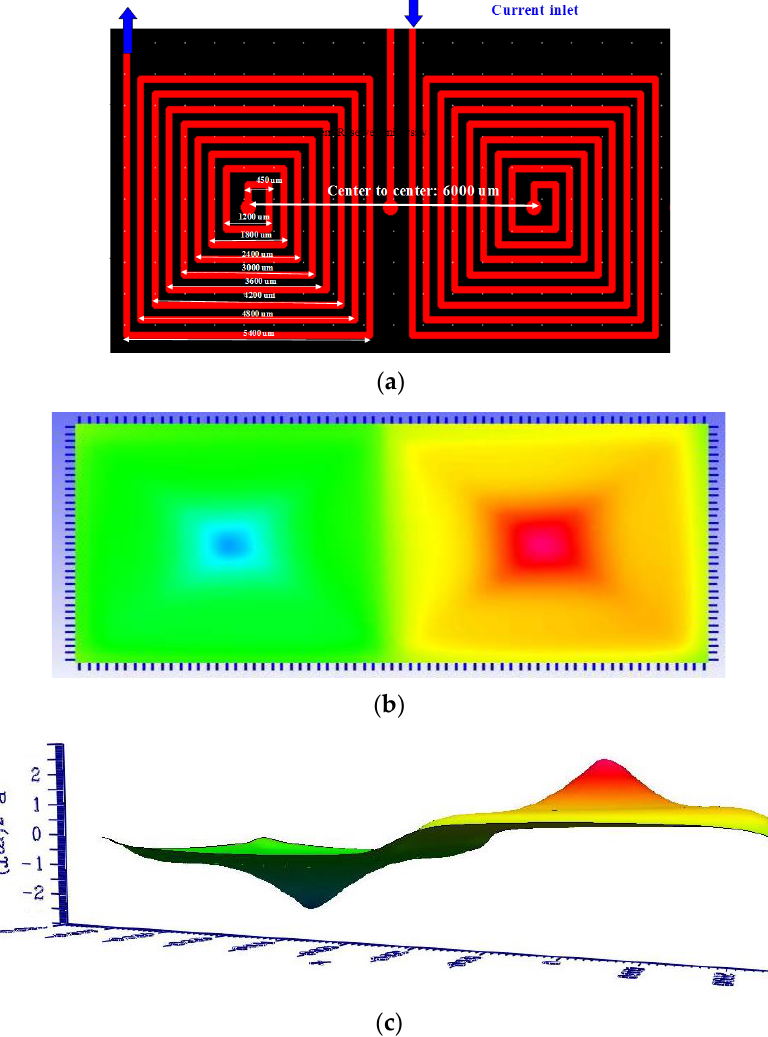
Figure 4. ( a ) Numerical geometry of two micro-coils. ( b ) 2D and ( c ) 3D numerical contours of the z -axial magnetic field at an applied electric current of 1.0 A. z -axial magnetic field at an applied electric current of 1.0 Table 2. Micro-coil geometry.